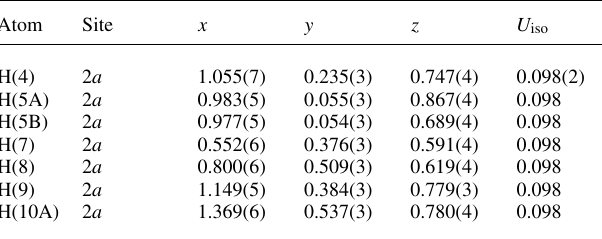
Table 2. Atomic coordinates and displacement parameters (in Å 2 )